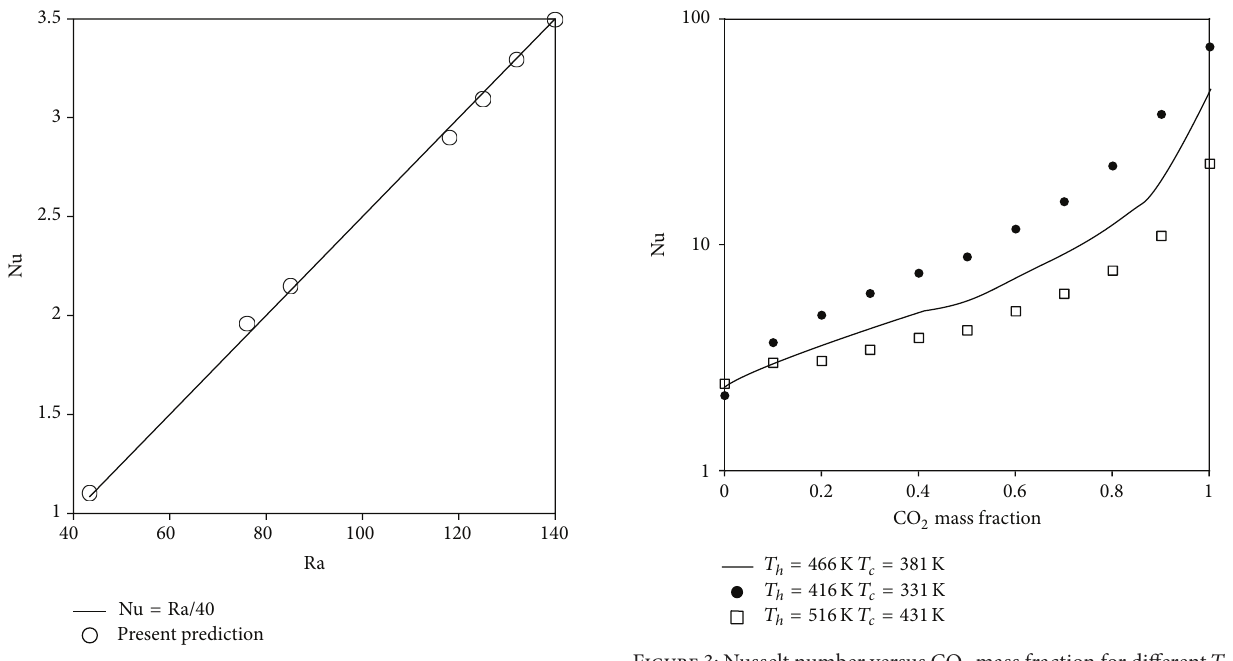
Figure 2: Validation of present CFD results against existing corre- lation for pure water.